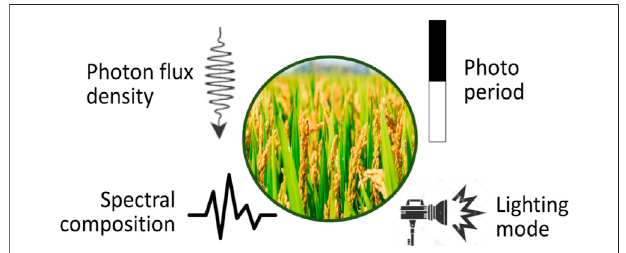
FIGURE 8 | Characteristics of the lighting regime relevant for crop